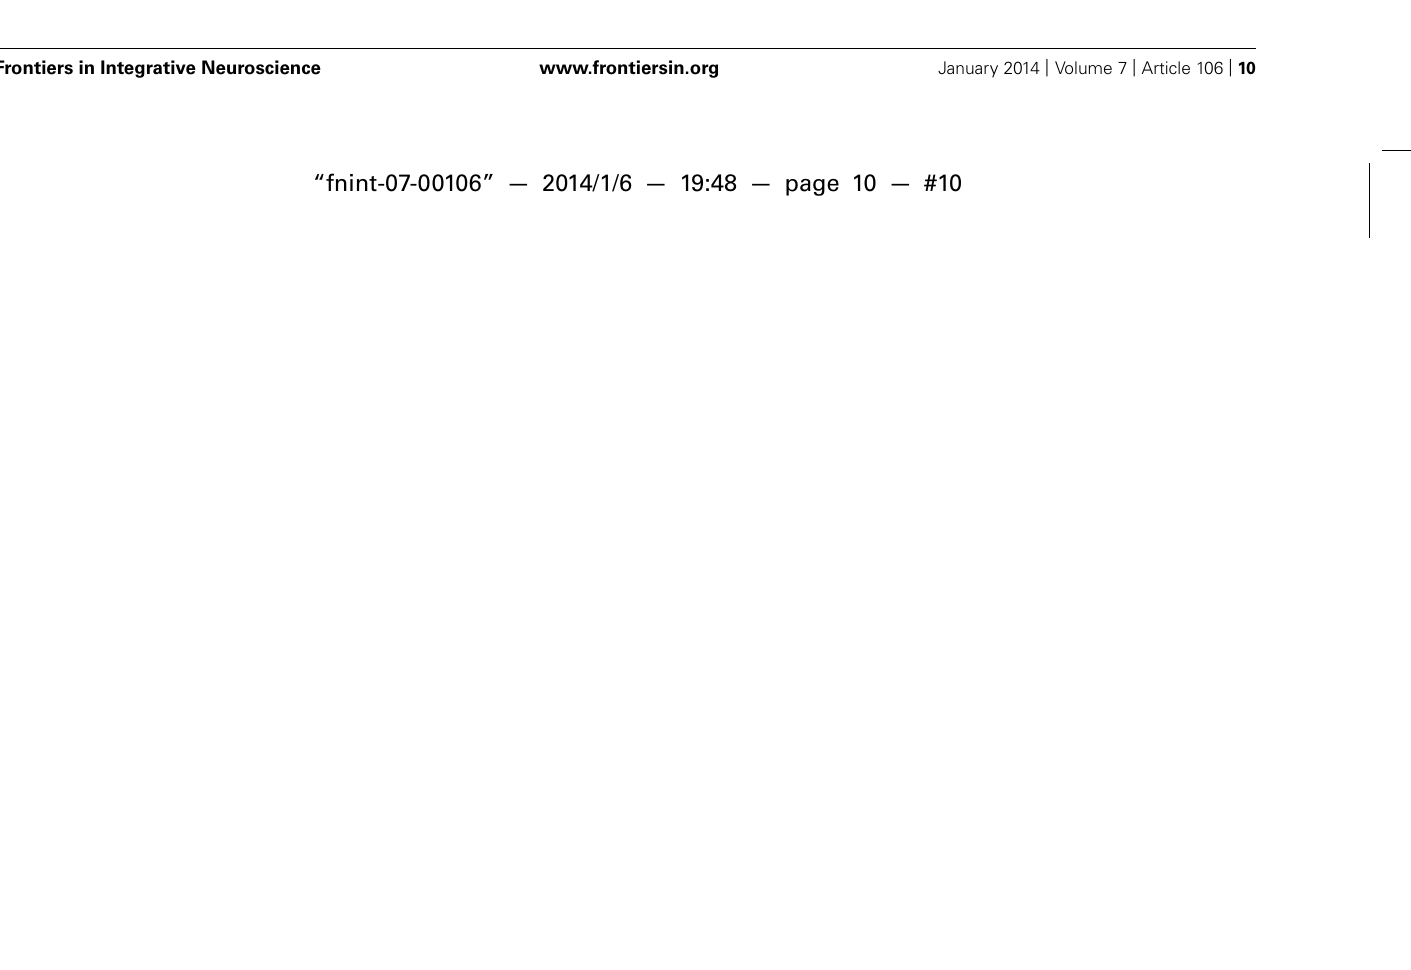
FIGURE 7 | Effects of repeated administration of cocaine and co-administration of cocaine (20 mg/kg) and Rimonabant (3 mg/kg) or AM630 (3 mg/kg) on microgliosis in the striatum (A) and the hippocampus (B) as measured with Iba-1 immunohistochemistry. AM630 and Rimonabant administration decreased the numbers of Iba1-ir cells observed in the striata but not the hippocampi of the repeated cocaine-treated rats. (C–P) Representative microphotographs showing low- and high-magnification (insets) views of microglial cells in the striatum and hippocampus.The histogram displays the means ± the SEMs ( n = 8/group) of the numbers of Iba1-ir cells per area (mm 2 ). One-way ANOVA: ∗ P < 0.05, ∗∗ P < 0.01, ∗∗∗ P < 0.001 vs. vehicle group; $ P < 0.05, $$ P < 0.01, $$$ P < 0.001 vs. repeated cocaine group; &&& P < 0.001 vs. AM630 group; # P < 0.05 vs. Rimonabant group. Scale bars are included in each